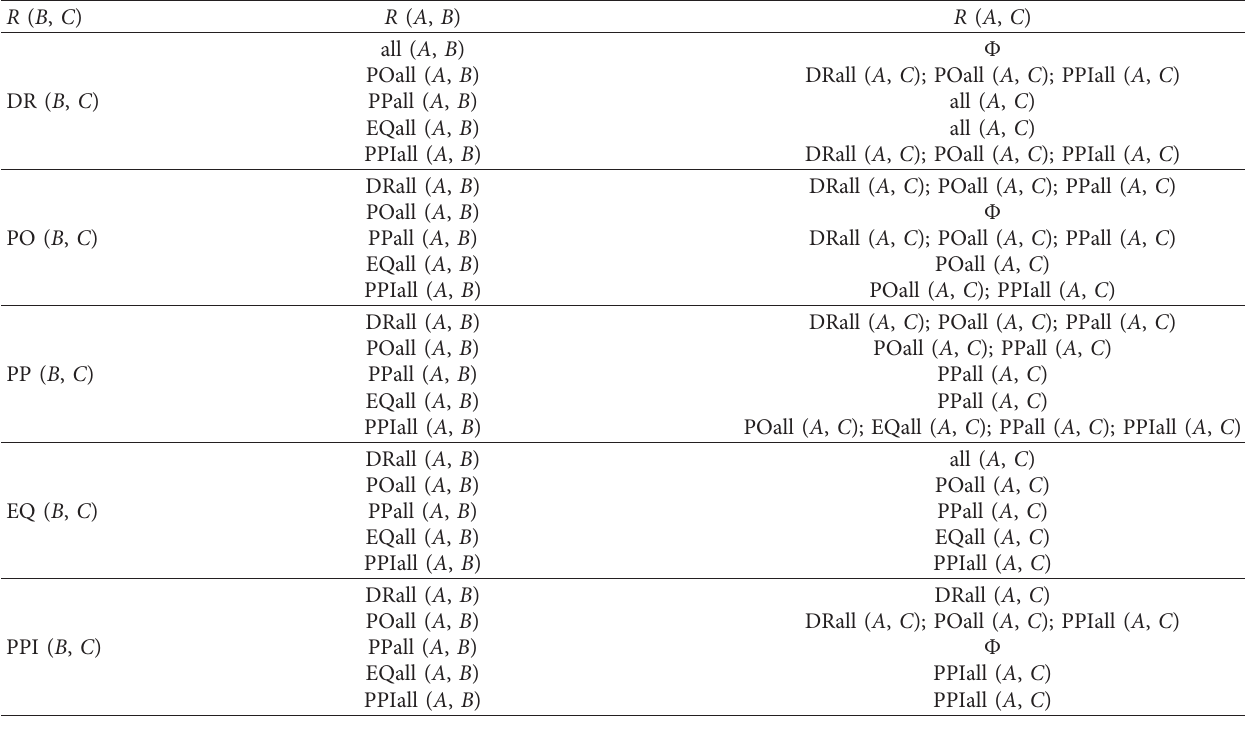
Table 4: Compound relationship reasoning